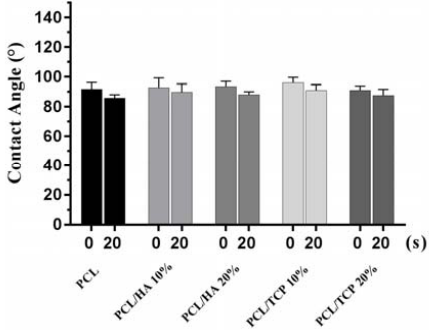
Figure 4. Contact angles obtained for all processed scaffolds at 0 s and 20 s, respectively.